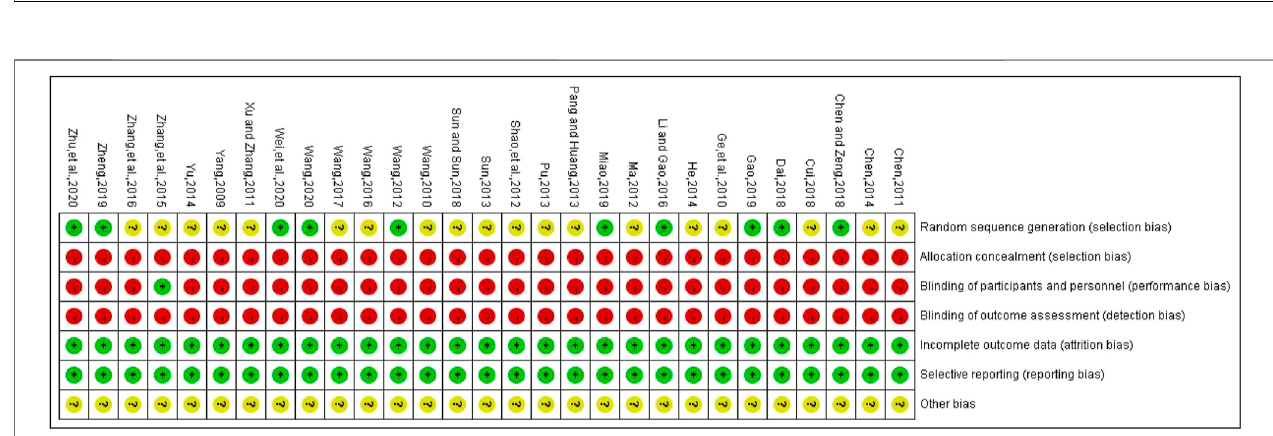
FIGURE 3 | Risk of bias for each included study. Red represents high risk of bias; green represents low risk of bias; yellow represents uncertain risk of bias.